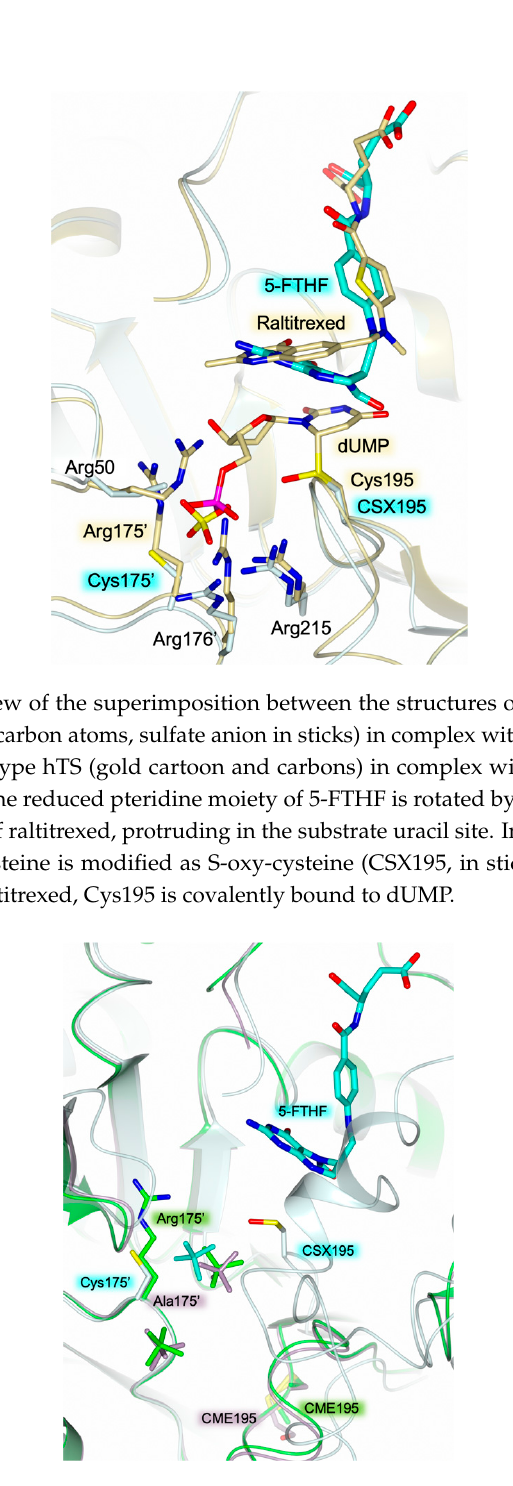
Figure 5. Active site view of the superimposition between the structures of HT-hTS R175C